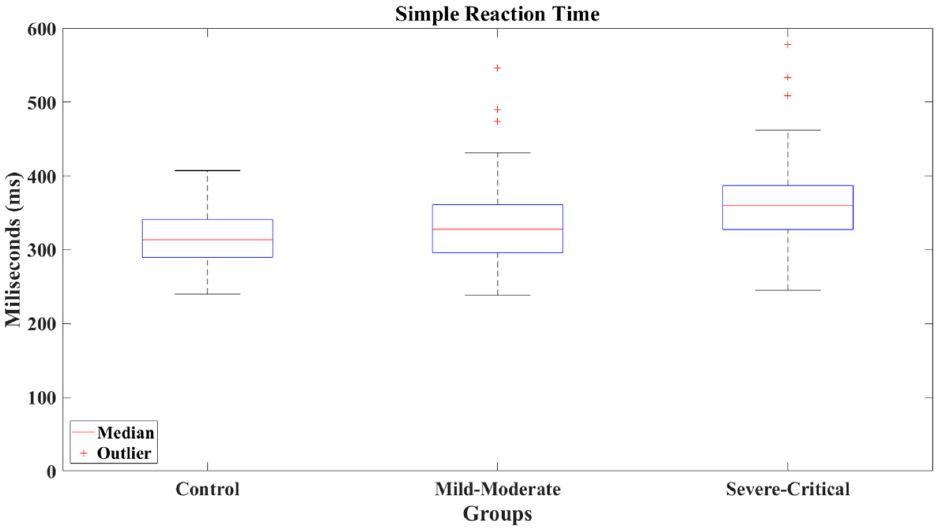
Figure 13. Simple reaction times by group.